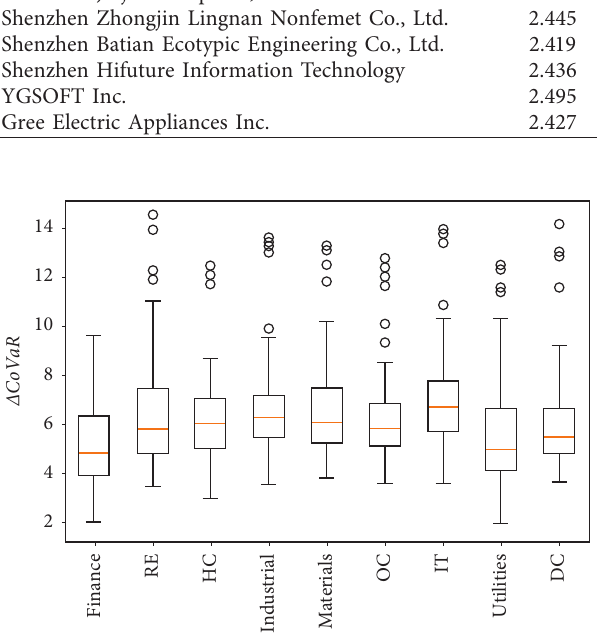
Figure 3: Box-and-line diagram of ∆ CoVaR after industry